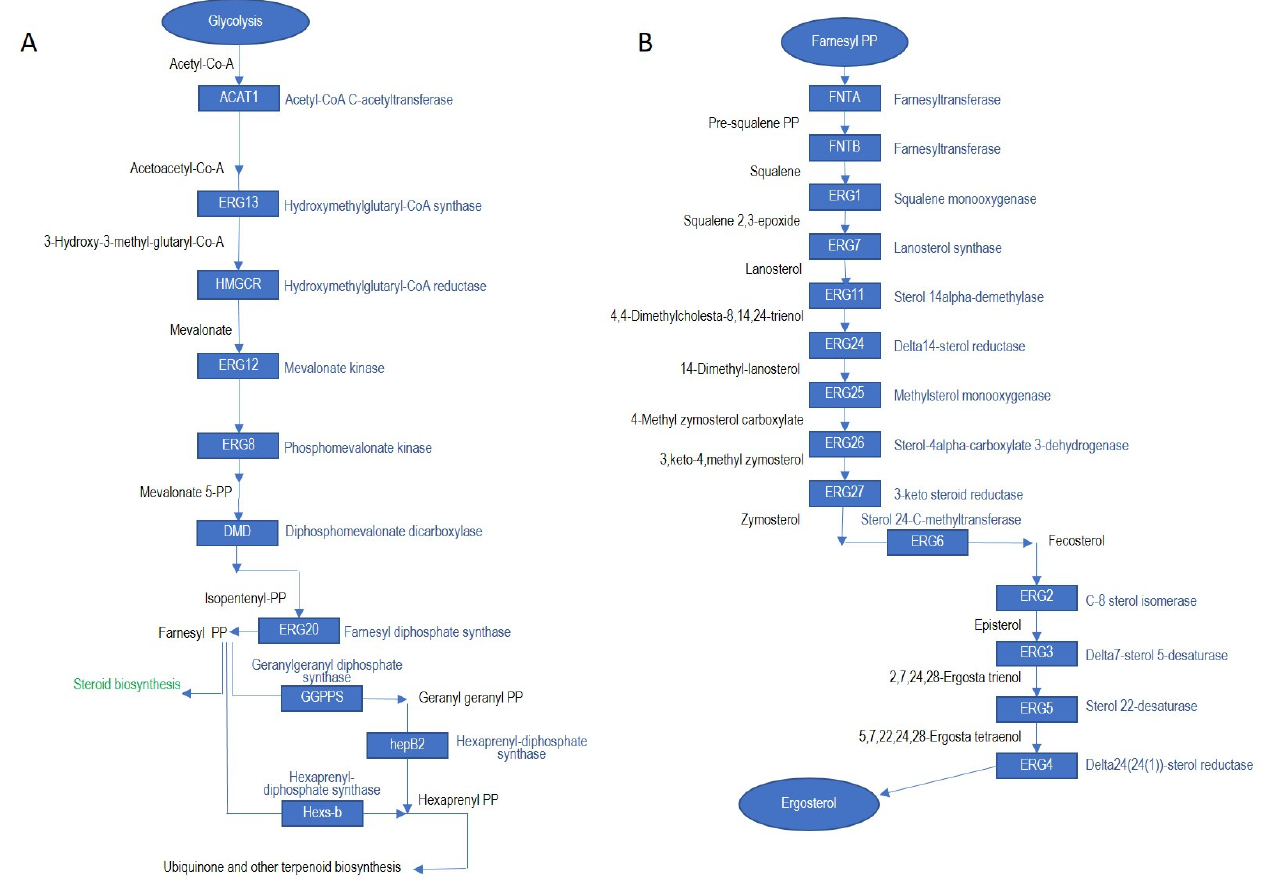
Figure 2. Possible ergosterol biosynthesis pathway in Ceratocystidaceae, as adapated from Bhattacharya et al. (2018). ( A ): the first part of the pathway from Acetyl-CoA to farnesyl pyrophosphate (FPP). ( B ): the last part of the pathway from FPP to ergosterol. ACAT1: Acetyl-CoA C-acetyltransferase, ERG13: Hydroxymethylglutaryl-CoA synthase, HMGCR: Hydroxymethylglutaryl-CoA reductase, ERG12: ERG12, ERG8: Phosphomevalonate kinase, DMD: Diphosphomevalonate dicarboxylase, ERG20: Farnesyl diphosphate synthase, GGPPS: Geranyl geranyl PP, hepB2: Hexaprenyl-diphosphate synthase, Hexs-b: Hexaprenyl PP, FNTA: Farnesyltransferase, FNTB: Farnesyltransferase, ERG1: Squalene monooxygenase, ERG7: Lanosterol synthase, ERG11: Sterol 14alpha-demethylase, ERG24: Delta14-sterol reductase, ERG25: Methylsterol monooxygenase, ERG26: Sterol-4alpha-carboxylate 3-dehydrogenase, ERG27: 3-keto steroid reductase, ERG6: Sterol 24-C-methyltransferase, ERG2: C-8 sterol isomerase, ERG3: Delta7-sterol 5-desaturase, ERG5: Sterol 22-desaturase, ERG4: Delta24(24(1))-sterol